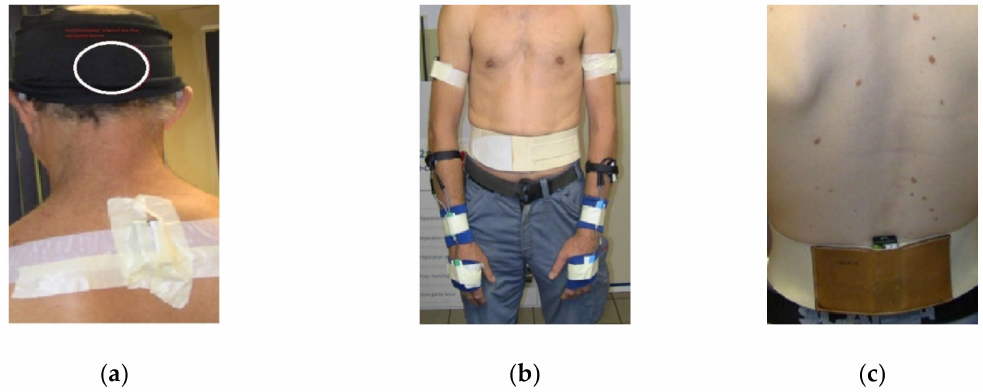
Figure 1. Placement of the sensors on the di ff erent body segments: ( a ) two inclinometers placed on the occipital bone and on the cervicothoracic spine at C7-T1 to measure the flexion / extension of the neck; ( b ) two tri-axial accelerometers placed in the lateral side of the right / left arms; ( c ) one accelerometer placed at L3 on the lower